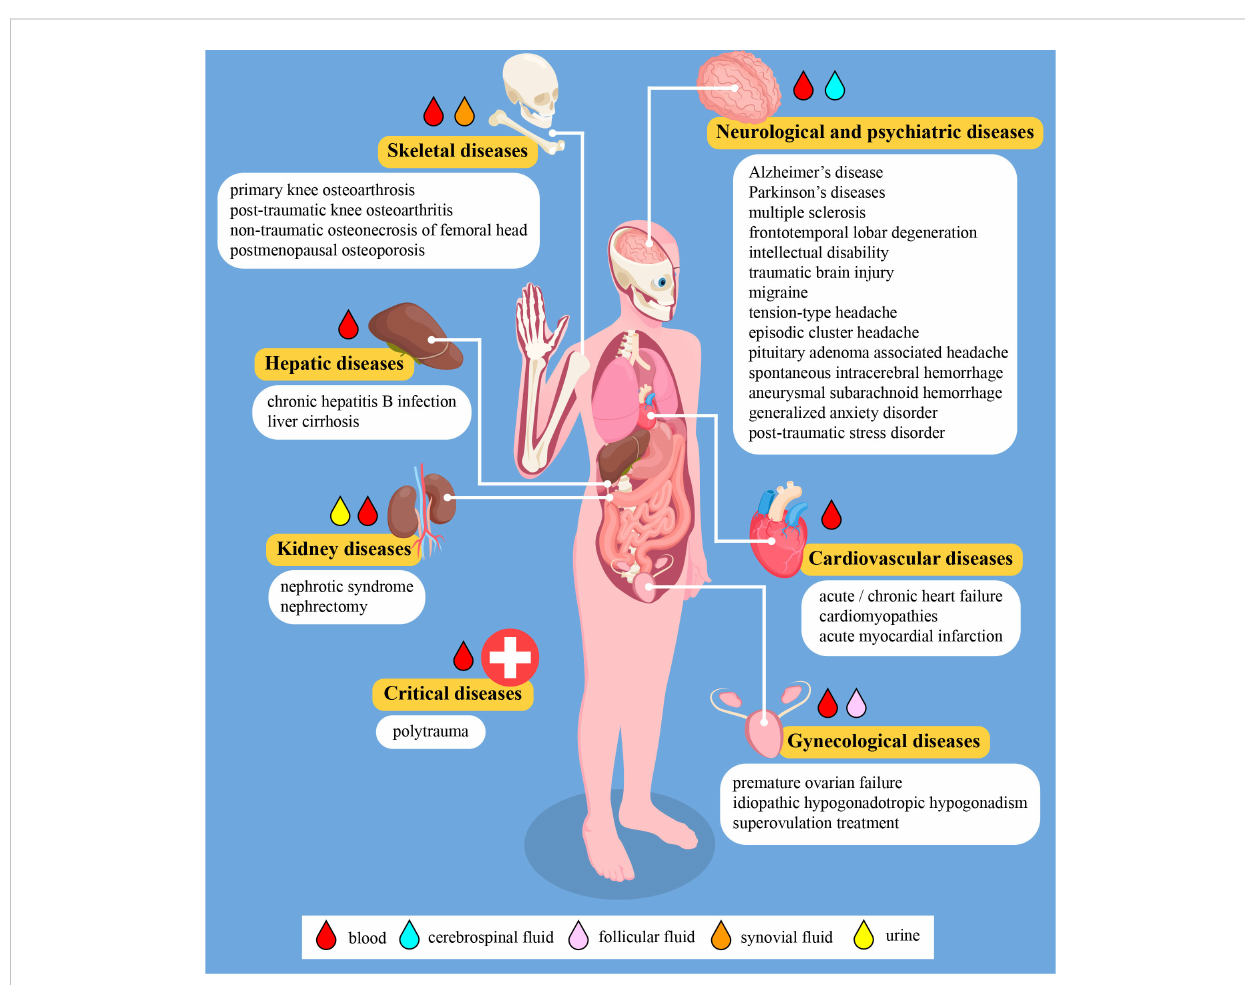
FIGURE 2 Schematic fi gure about human diseases where changes of the PACAP levels were investigated. The fi gure contains modi fi ed elements designed by macrovector/Freepik